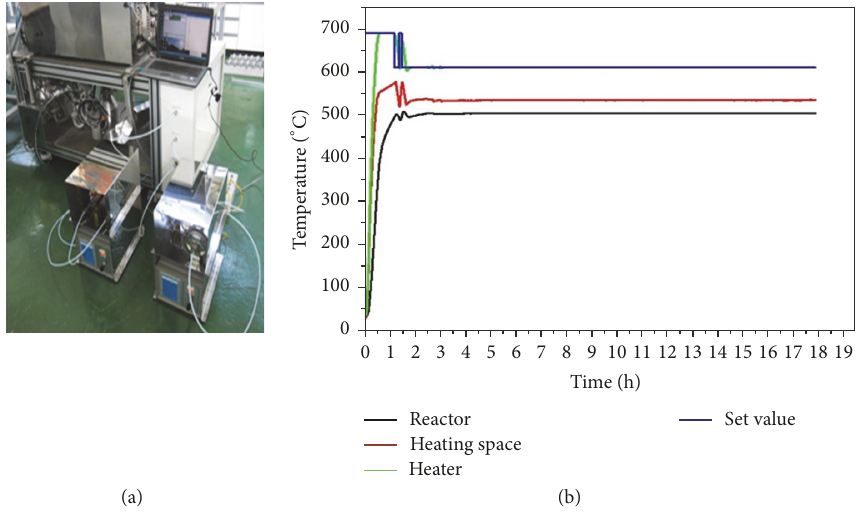
Figure 18: Heating test of the prototype device: (a) temperature test equipment; (b) test